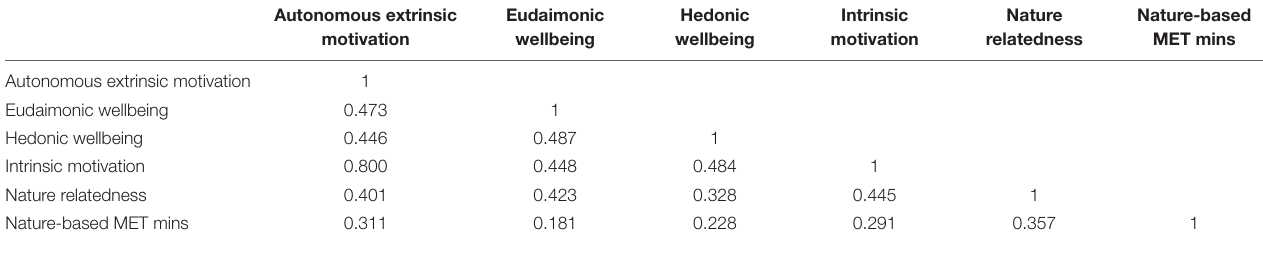
TABLE A1 | Correlation matrix among latent